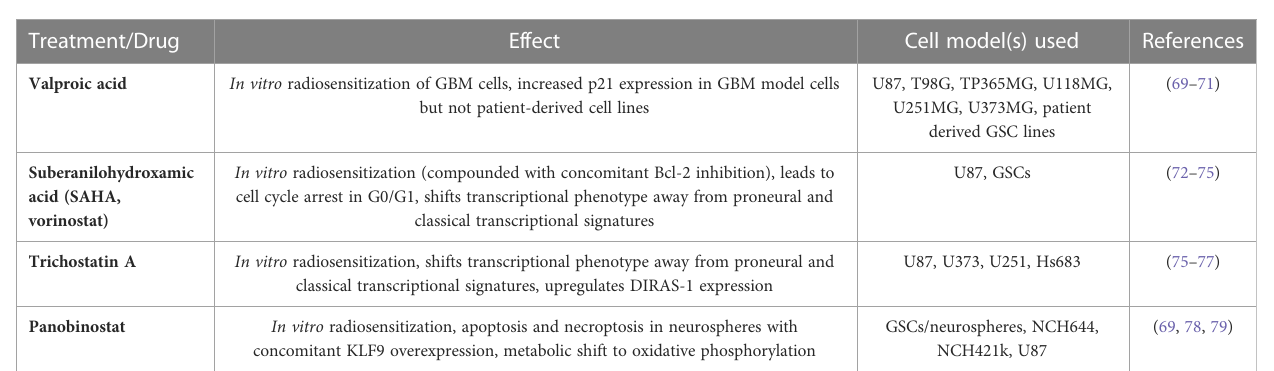
TABLE 2 The effect of select HDAC inhibitors in GBM